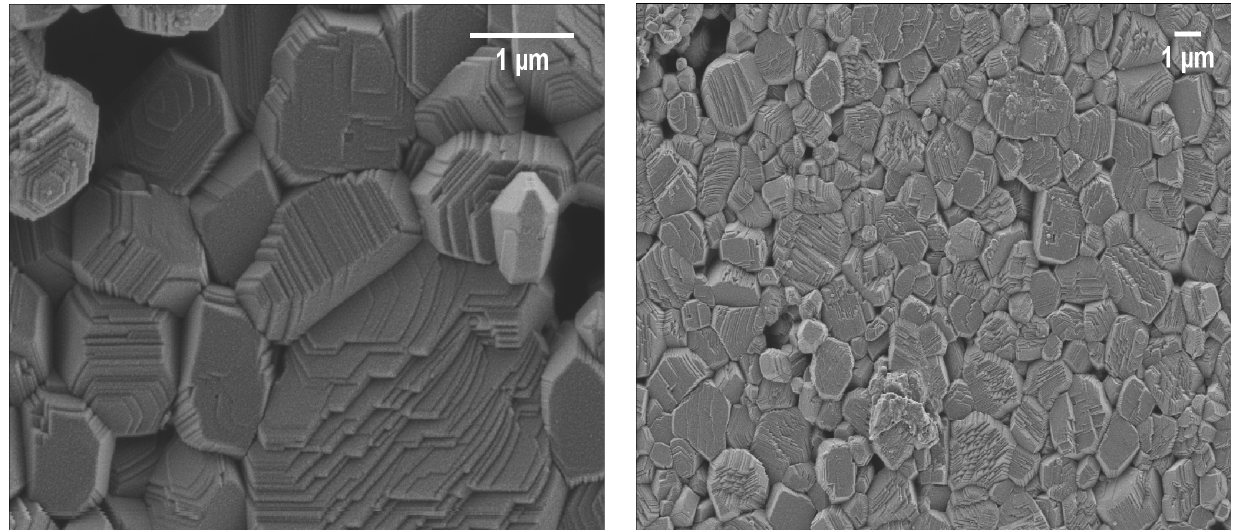
Figure 6. Microstructure of ceramics sintered at 1350 o C by the SPS method: BMW-host ( top row ), BMW-Eu ( center row ), BMW-Nd ( bottom row ). The images on the right and left sides only differ in terms of magnification.